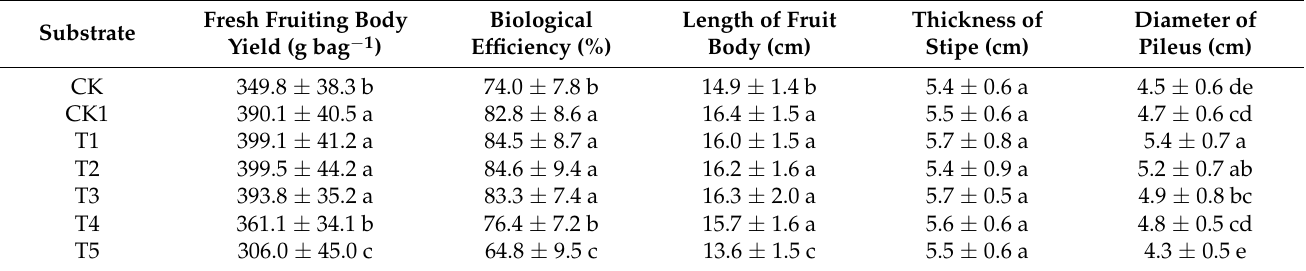
Table 2. Agronomic traits of P. eryngii cultivated on different substrates # .